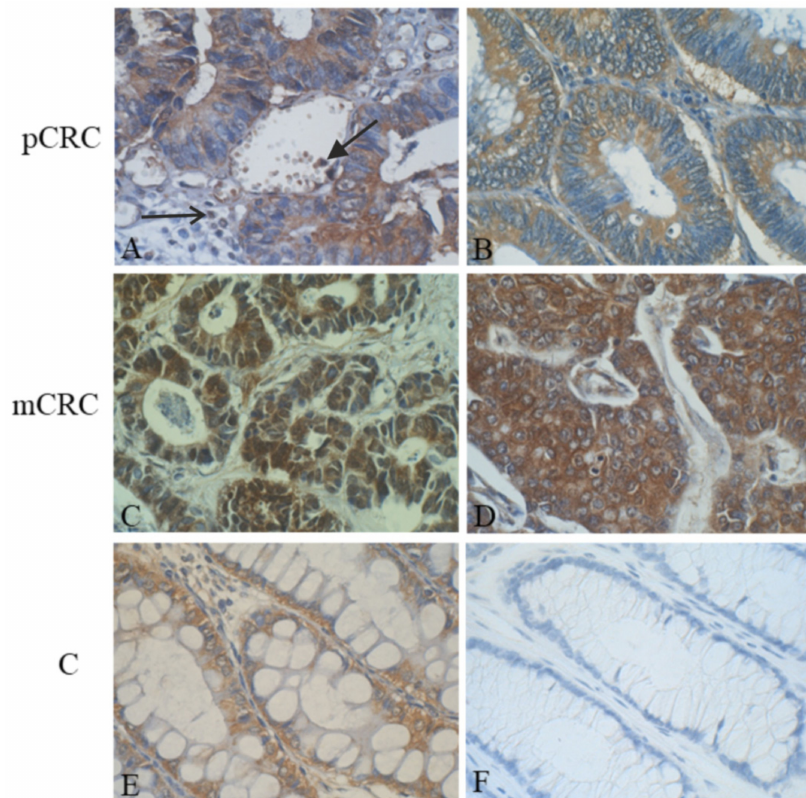
Figure 1. Immunohistochemical (IHC) localization of insulin-like growth factor (IGF) 2 in primary colorectal cancer (pCRC), metastatic colorectal cancer (mCRC), and control colon (C) samples: ( A ) A representative IHC expression of IGF2 mainly in cytoplasm of surface epithelium of tumor-changed colon crypts, in few white blood cells (arrowhead), and in individual cells of the tumor stroma (arrow); ( B ) homogenous cytoplasmic IHC reaction in neoplastic cells lining the glandular structures of colorectal cancer (CRC); ( C ) an intense IHC reaction of IGF2 in the cytoplasm and nuclei of numerous cancer cells present in lymph node metastatic carcinoma; ( D ) very strong cytoplasmic IHC reaction of IGF2 in cancer cells of lymph node metastatic CRC of other patient; ( E ) cytoplasmic expression of IGF2 in majority of goblet cells in normal colon epithelium; and ( F ) negative IgG control. New polymer-based immunohistochemistry with 3,3 (cid:48) -Diaminobenzidine (DAB) was the chromogen. Hematoxylin counterstained. Objective × 40 (Figure 1 A – F ) (our unpublished